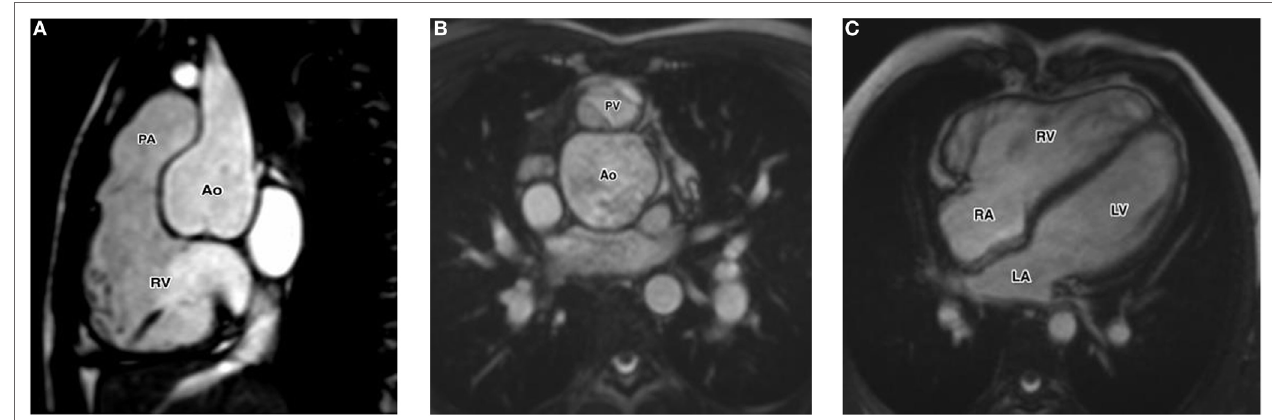
FIGURe 1 | (a) Cardiac MRI with sagittal view of the right ventricular outflow tract showing the anterior leaflet of the pulmonary valve without attachment to the annular hinge. (B) Cardiac MRI with axial view of the pulmonary valve showing morphologic abnormality of the anterior leaflet. (C) Cardiac MRI with four-chamber views showing the dilatation of the right ventricle. Abbreviation: LA, left atrium; LV, left ventricle; RA, right atrium; RV, right ventricle.